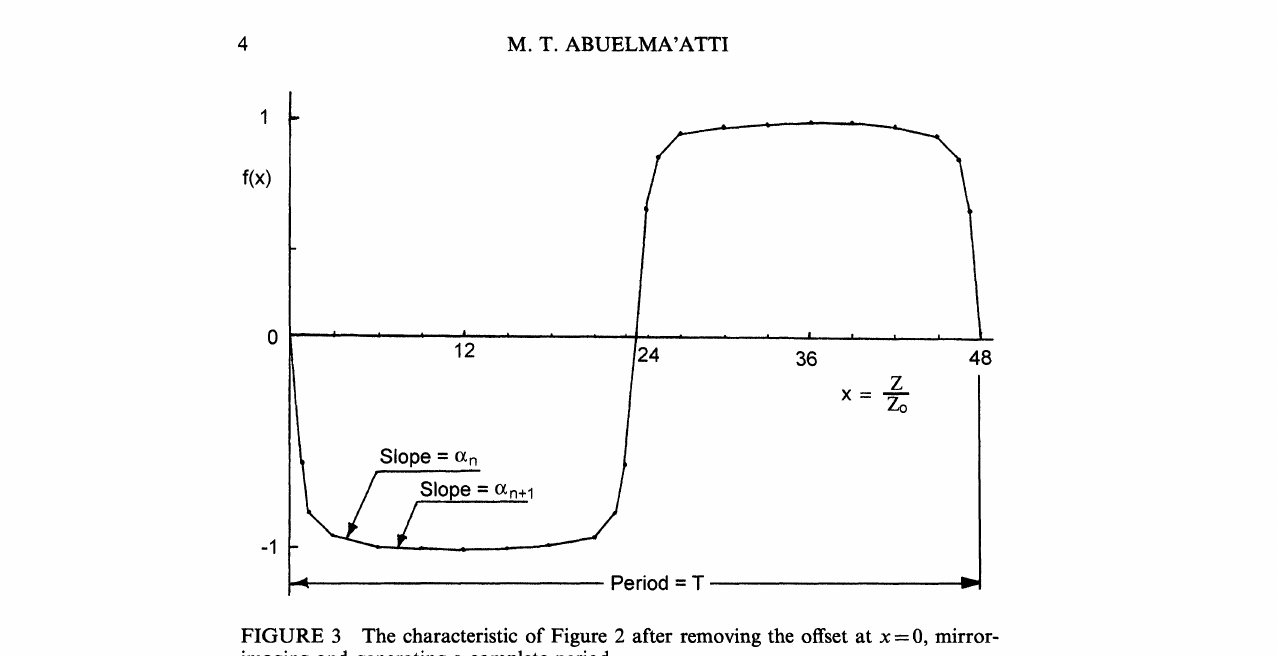
FIGURE 3 The characteristic of Figure 2 after removing the offset at x =0, mirror- imaging and generating a complete